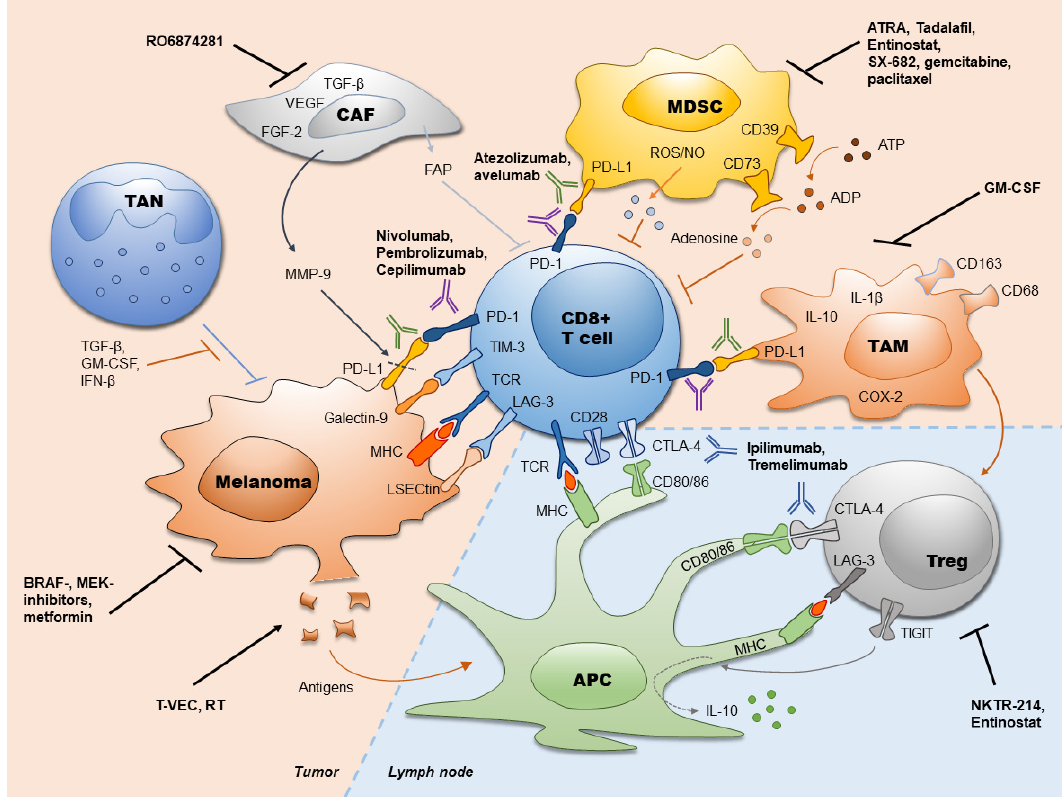
Figure 1. Immune checkpoint inhibitors in melanoma and their combination with other therapies. Currently used antibodies against PD-1 (atezolizumab, avelumab), PD-L1 (nivolumab, pembrolizumab, cepilimumab) and CTLA-4 (ipilimumab, tremelimumab) as well as strategies to